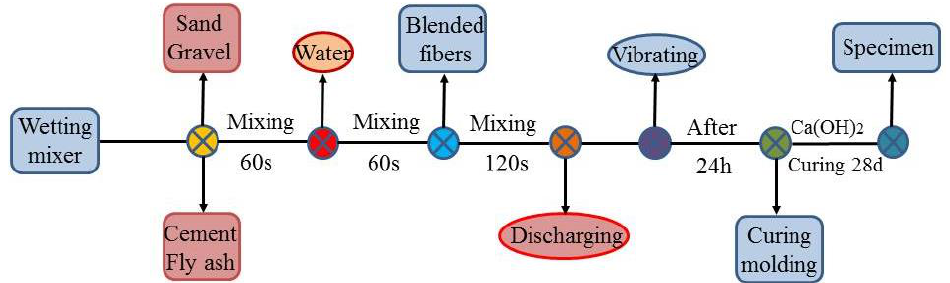
Figure 2. The mixing steps of